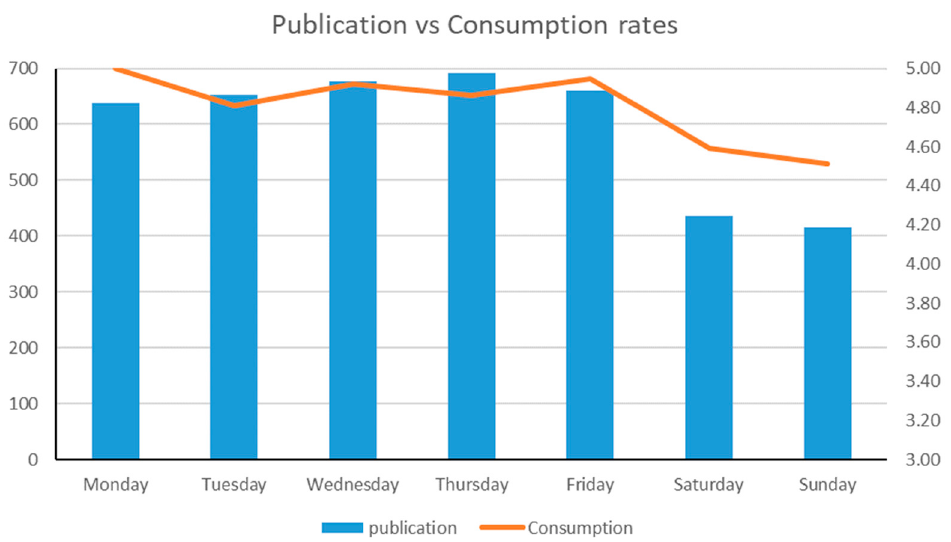
Figure 1. Comparison of the average number of published articles and reported consumption rates during weekdays and weekends.